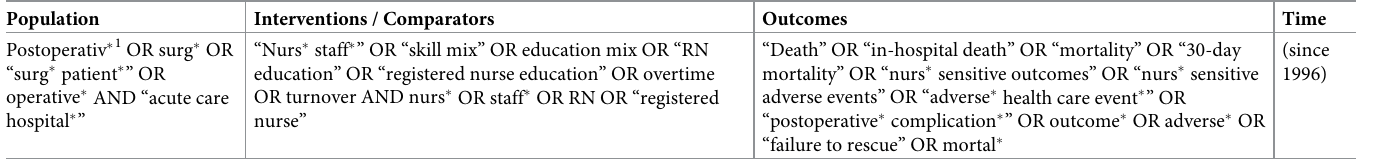
Table 1. Keywords used for the electronic searches.